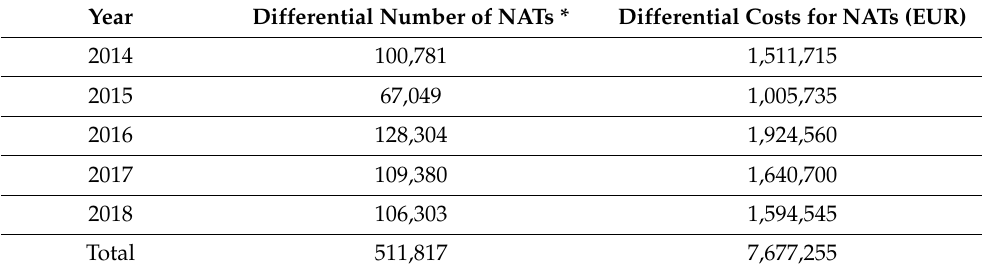
Figure 2. Annual costs per type of human surveillance (hospitalization ( a ) and NAT test ( b )). Table 7. Costs related to surveillance activity